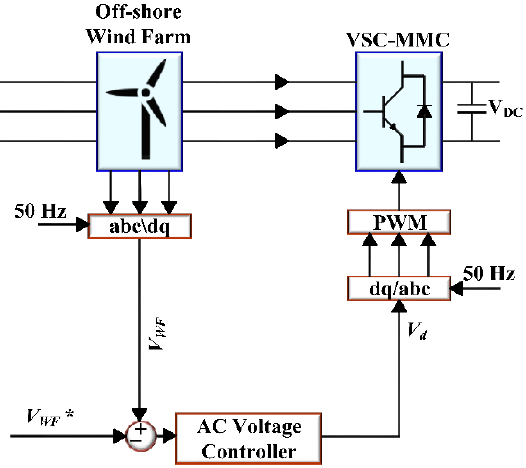
Figure 4. AC voltage controller schematic for wind farms .